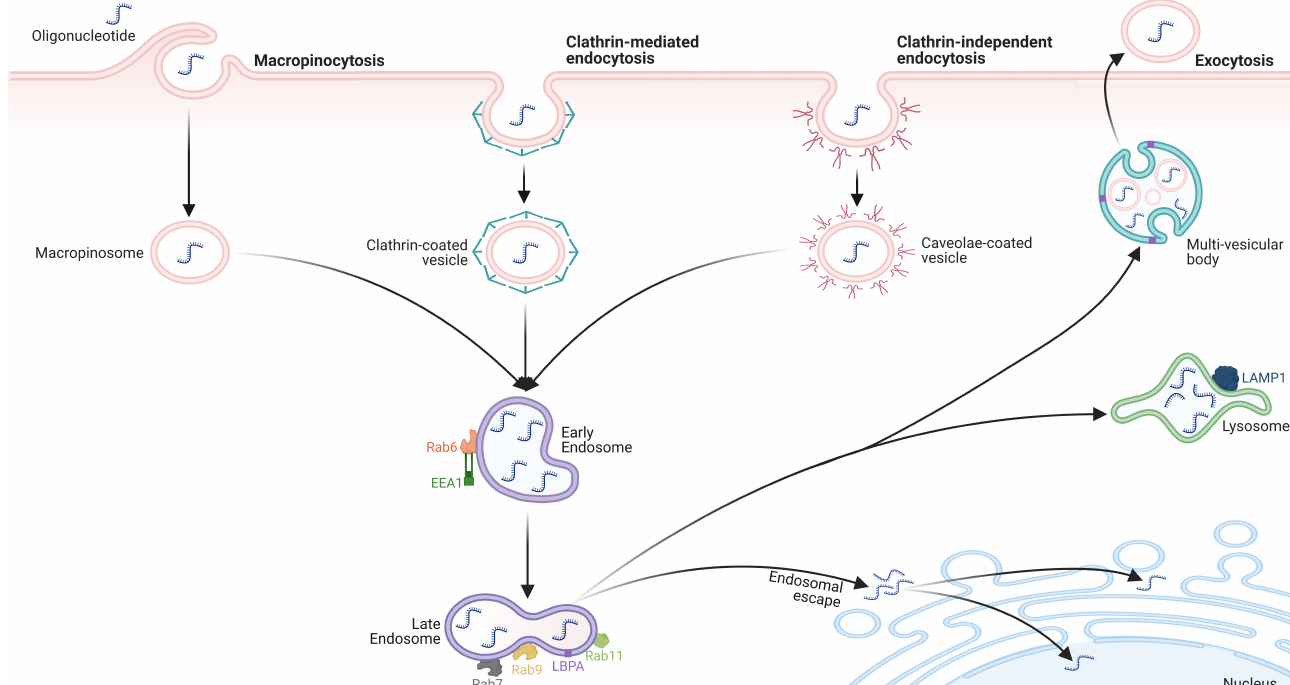
Figure 5. This is a wide figure. Figure 4. A simplified overview of the gymnotic ON uptake mechanism. ON uptake through gymno- sis and subsequent endosomal escape is a complex and multifactorial process. Major identified ON internalization routes include clathrin-dependent endocytosis, clathrin-independent endocytosis, and macropinocytosis, each representing a distinct ON uptake mechanism into cells. Once internalized, ONs are transported through a series of endosomal compartments sequentially, first to the early endosome (pH range: 6–7) and then to the late endosome (pH range: 5.5–6). At this point, ONs may be directed towards the lysosome (pH range: 4.5–5) for degradation or towards multivesicular bodies for exocytosis. The late endosome membrane remodeling and transition to multivesicular bodies or lysosomes have been identified as potential points of endosomal escape, as these stages in the endosomal pathway are thought to represent opportunities for ONs to bypass degradation and reach their intended targets. Various markers have been proposed for tracking the endosomal pathway, including Ras-associated proteins 6, 7, 9, and 11 (Rab6, Rab7, Rab9, and Rab11), early endosome antigen 1 (EEA1), lysobisphosphatidic acid (LBPA), and lysosomal-associated membrane protein 1 (LAMP1), which can be utilized to monitor the progression of ONs through the endosomal pathway and identify potential points of endosomal escape (Created with BioRender: